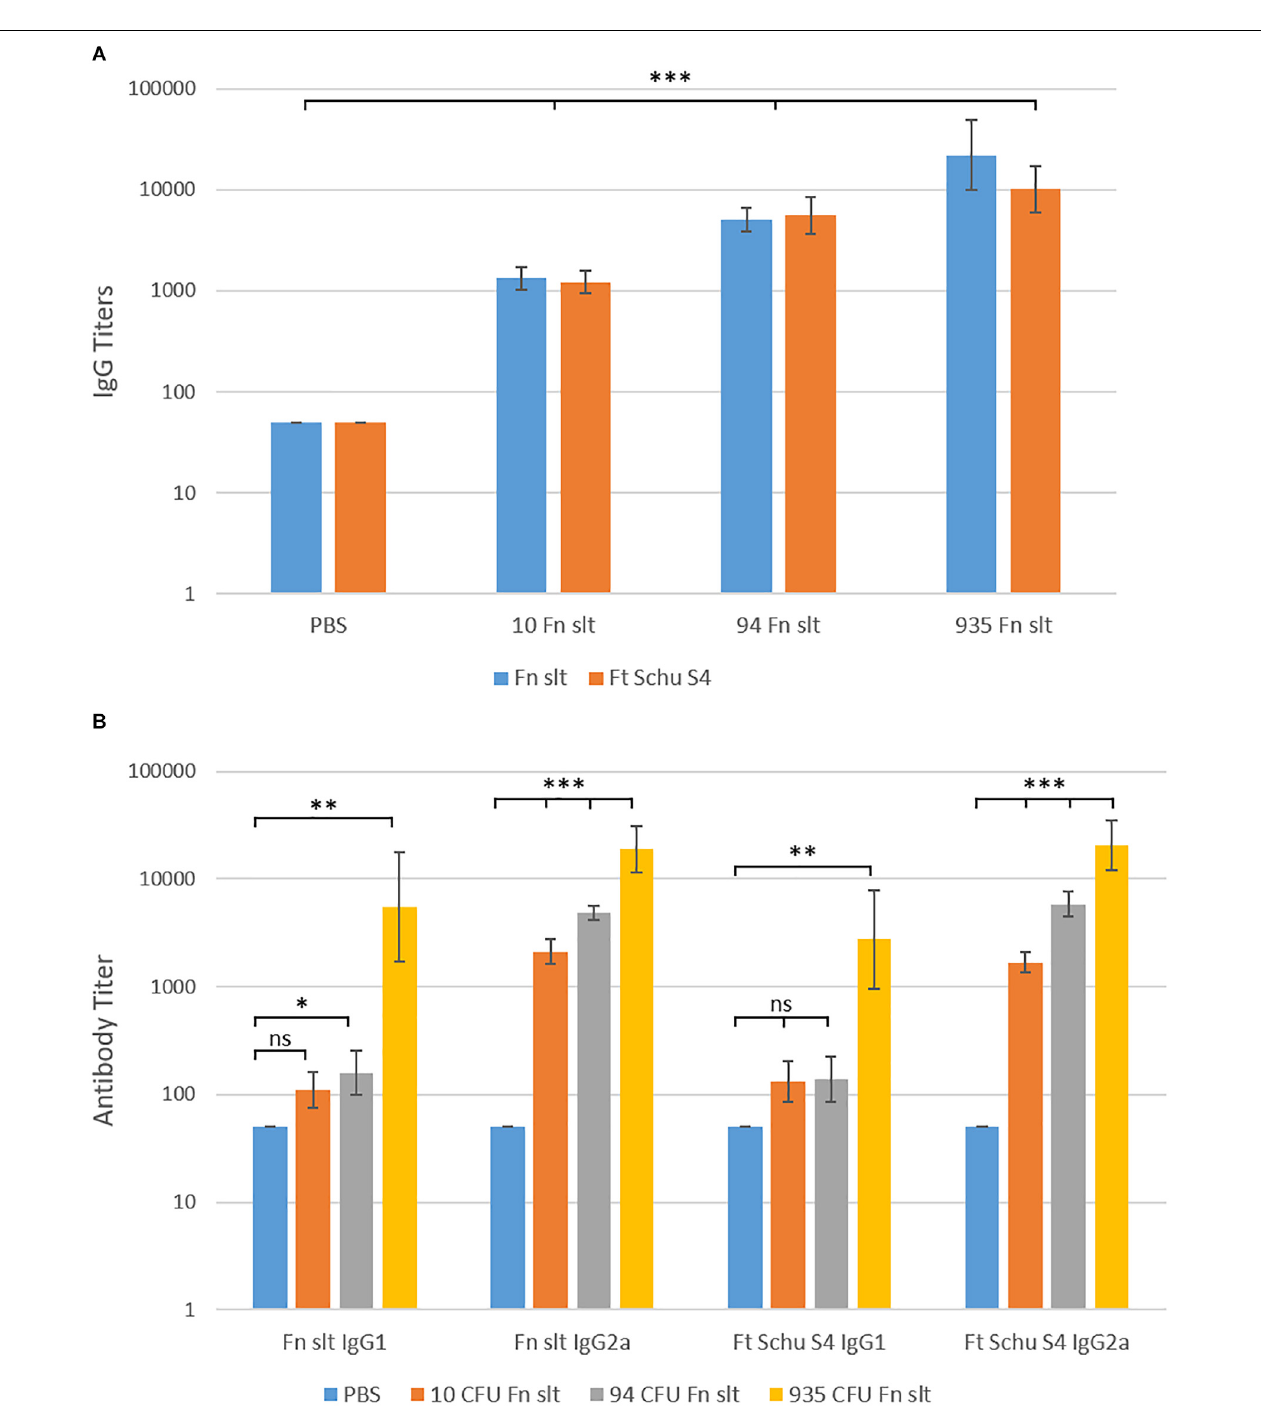
FIGURE 11 | Serum IgG, IgG1, and IgG2a antibody titer levels by ELISA. Sera were collected from BALB/c mice vaccinated with mock/PBS ( n = 5), 10 ( n = 5), 94 ( n = 5), and 935 ( n = 3) CFU Fn slt mutant. The reactivity of (A) total IgG, (B) IgG1 and IgG2a in serum was tested against Fn slt or Ft Schu S4 by endpoint ELISA. Statistical significance was determined by t -test on log10 values compared against PBS only control; ns, not significant, ∗ P < 0.5, ∗∗ P < 0.01, ∗∗∗ P < 0.001.